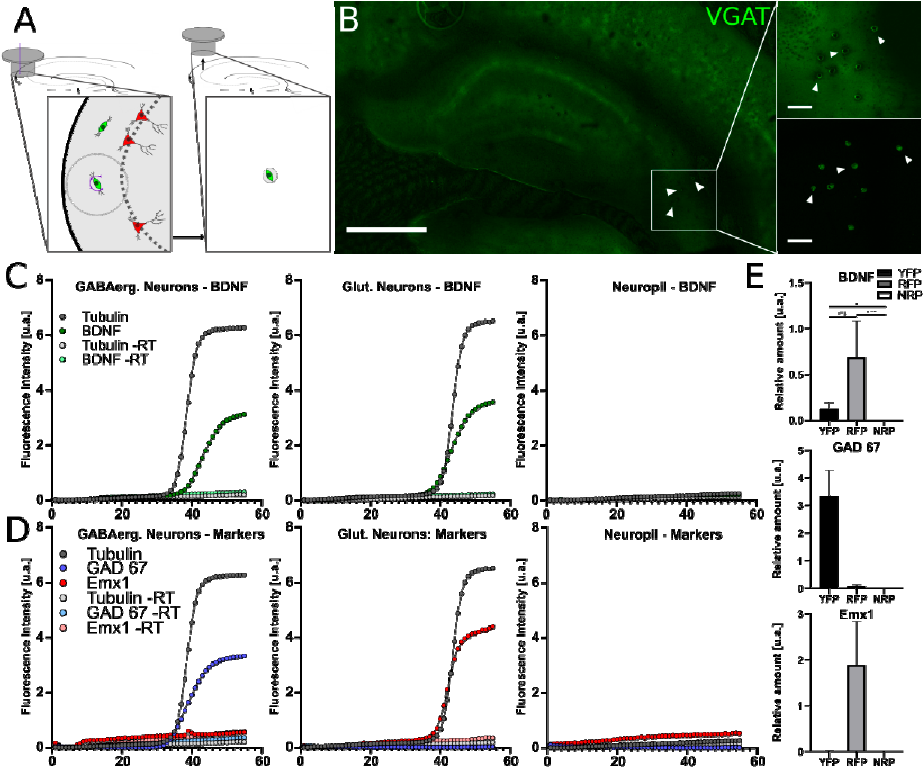
Figure 5. Laser capture microdissection (LCM) and reverse transcription quantitative PCR (RT-qPCR) from microdissected hippocampal glutamatergic and GABAergic neurons. BDNF mRNA quantification from tissue slices following LCM and RT-qPCR: ( A ) Scheme of the LCM procedure. Cells expressing specific reporter genes can be identified through fluorescence microscopy and dissected, and their cell bodies can be harvested from the surrounding tissue. ( B ) Fluorescence image of a tissue section processed for LCM. Insets show the site of the removed sample (top) and the sample (bottom) following the microdissection of GABAergic cell bodies from the stratum oriens (arrowheads). ( C ) Fluorescence intensity vs. cycle plots for RT-qPCR amplification of BDNF and class III β -tubulin, in laser-captured GABAergic neurons (left), glutamatergic neurons (middle) or neuropils (right). ( D ) Intensity vs. cycle plots for RT-qPCR amplification of neuron type-specific transcripts: GAD67 (GABAergic) and Emx1 (glutamatergic), as well as class III β -tubulin (as reference), for the three samples. ( E ) Summary bar charts of the quantification of BDNF, GAD67 and Emx1 target genes normalized to class III β -tubulin, as a neuron-specific “housekeeping” control. Scale bar: (B), 1000 µm; insets, 100 µm.